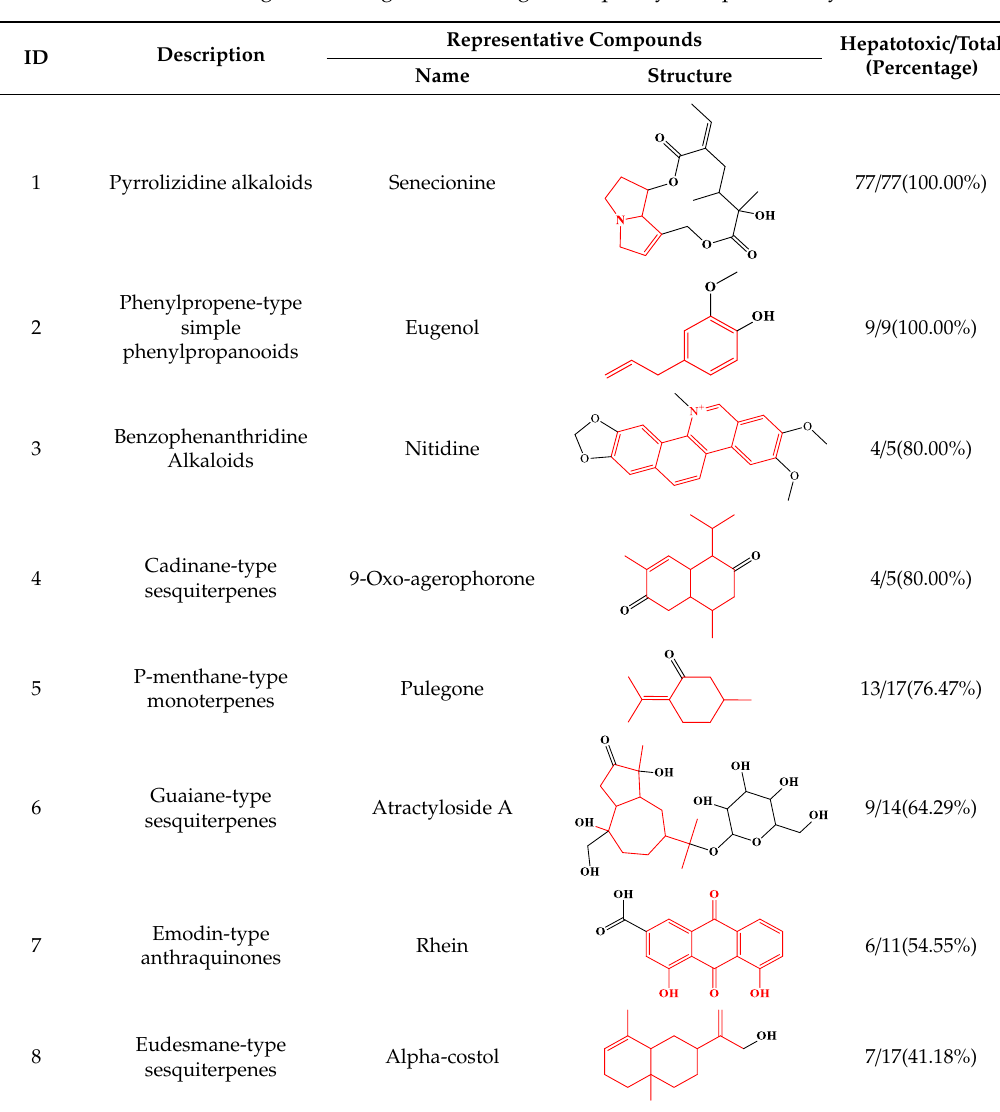
Table 4. Eight sub-categories with higher frequency of